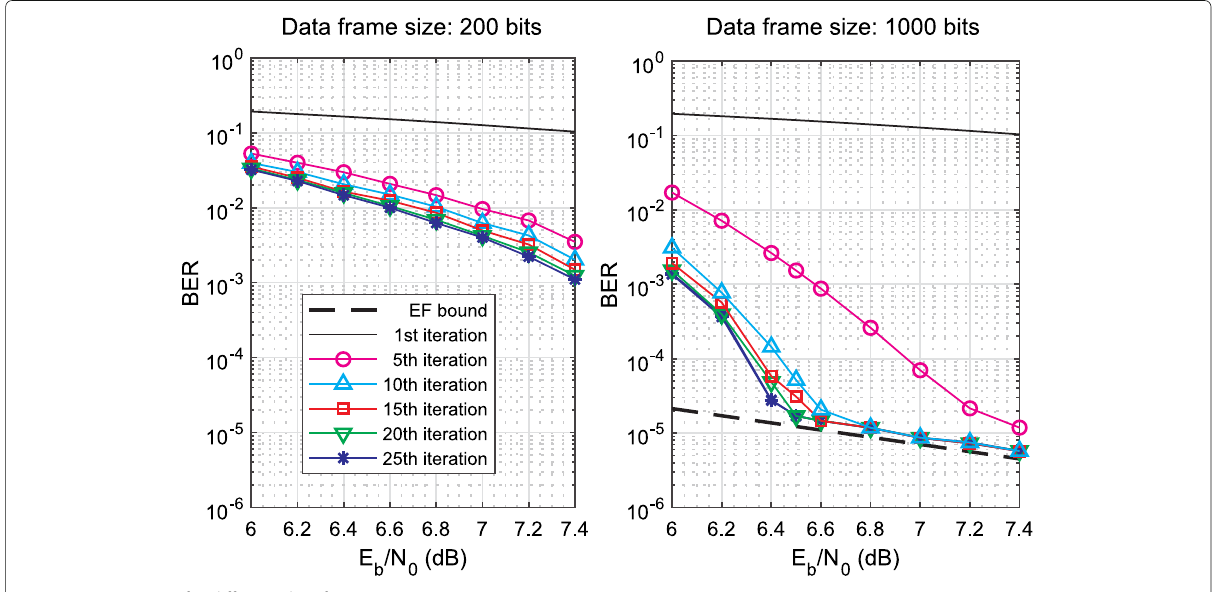
Fig. 2 BER vs. E b / N 0 for different data frame